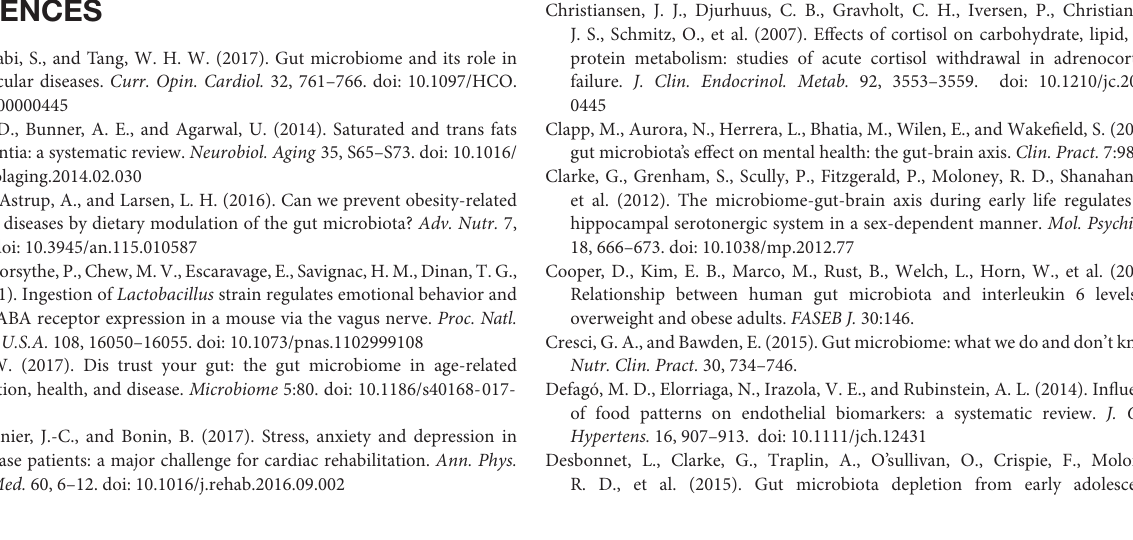
Table 1 Mechanistic pathways, mediators and main microbiome modifications associated with stress related psychological disorders. Molecular signaling pathways linking the microbiome with stress-related health outcomes. Several studies related to preclinical models of bacterial infections, probiotics treatment and analysis of germ-free (GF) animals suggest that the microbiota can influence the CNS and consequently behavior. Stress-related disorders such as anxiety and depression are among the main psychiatric conditions associated with microbiome changes (Desbonnet et al., 2010, 2015; Bravo et al.,